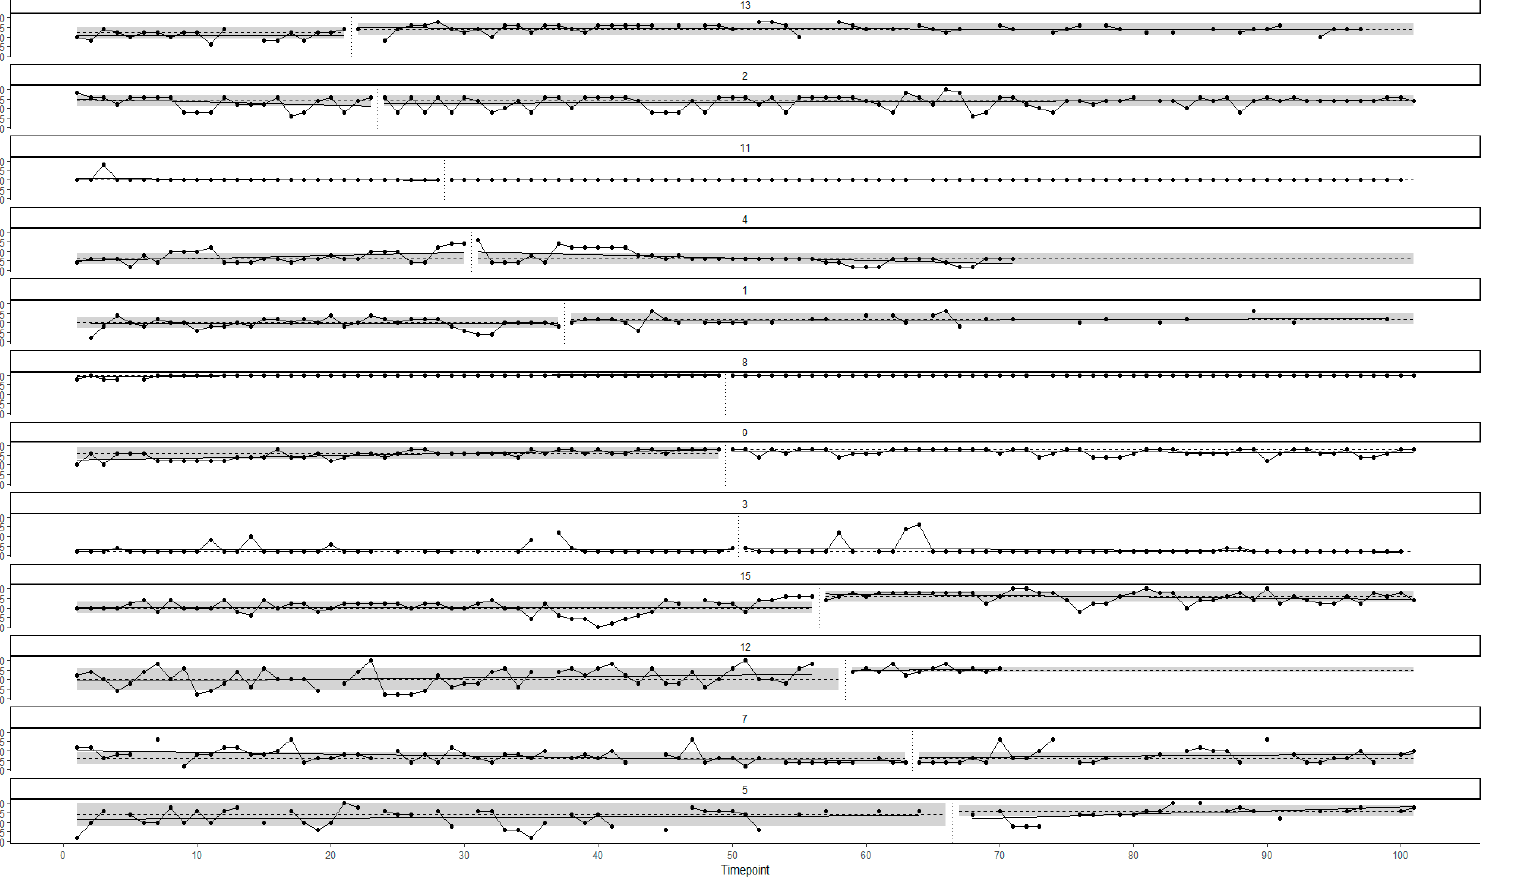
Figure A6. SCED data for all participants on daily measure of valued action. Note: Participant data are ordered via the order in which they received the intervention. Vertical dotted lines denote the data point at which the intervention was delivered. Shading denotes the one median absolute deviation from the median. Dashed horizontal lines denote the median while solid lines denote within-phase OLS regression trend lines.